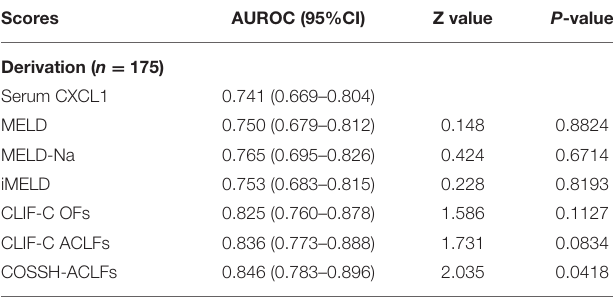
TABLE 4 | Comparison of the predictive value of prognostic scoring systems for patients with HBV-ACLF on 28-day survival.